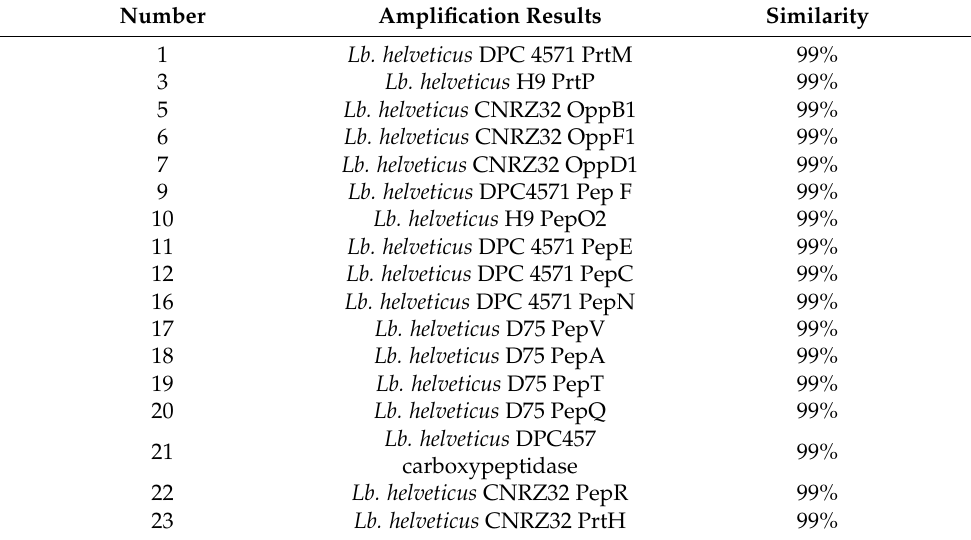
Table 3. Gene amplification results of the proteolysis